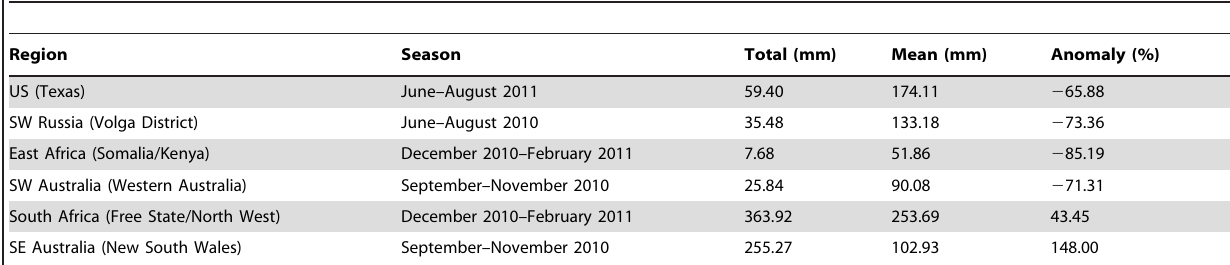
Table 1 . Total seasonal rainfall, long-term means, and anomalies for 2010–2011 extracted from the Global Precipitation Climatology Project [31] for regions presented in Figure